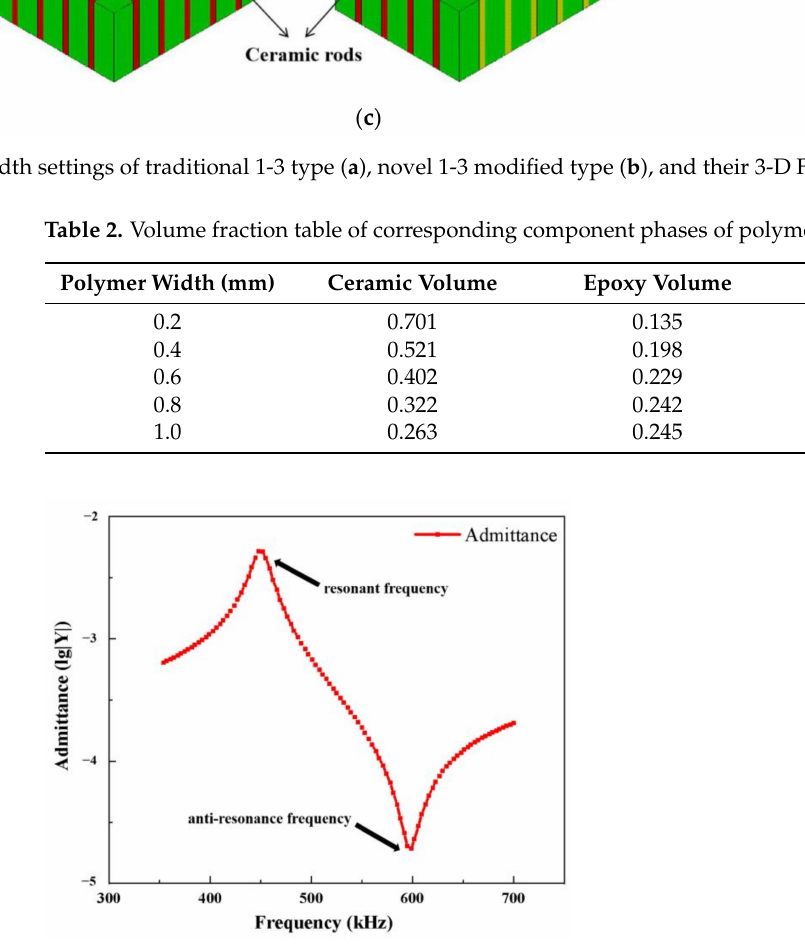
Figure 7. Admittance curve of modified 1-3 piezoelectric composite ( c = 0.6 mm). The resonant frequency is the frequency that affects the maximum response of the piezoelectric transducer due to external excitation. In accordance with the different widths of the polymer phase, the resonance frequencies of the two types of composite are anisotropic (Figure 8) and gradually increase with the decrease in the polymer phase volume fraction and the resonance frequency of the two composites. For the traditional 1-3 type composite, the change of polymer phase volume fraction on the resonance frequency of the vibrator is within 0.2–1.0 mm, with the resonance frequency maximum change being approximately 50 kHz. By contrast, the change of the modified type 1-3 composites